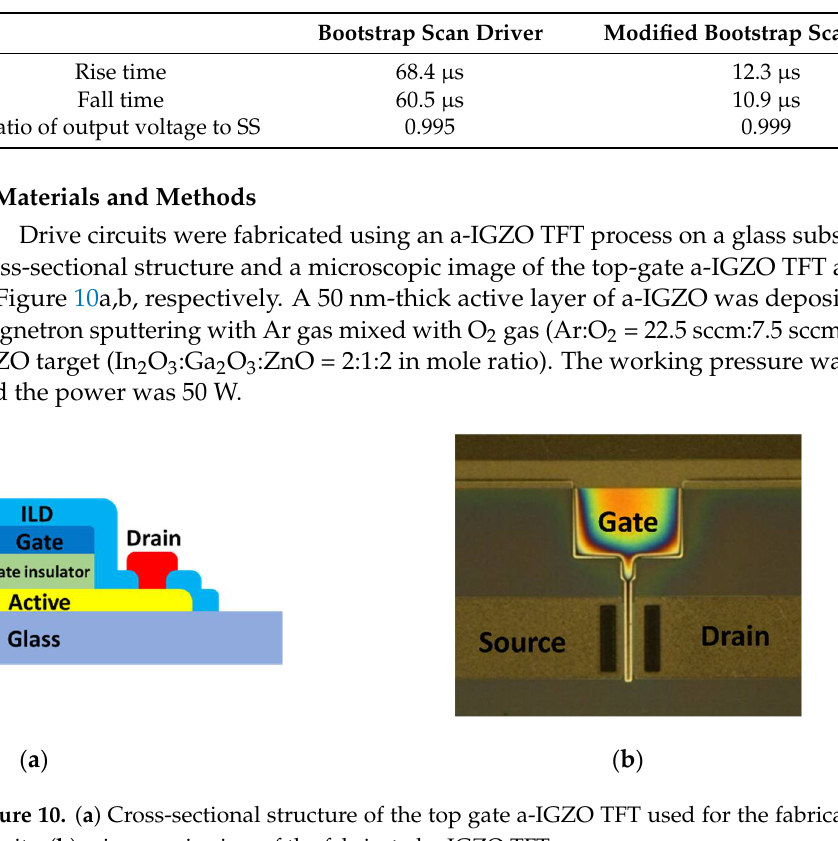
Table 2. Comparison of driving characteristics of bootstrap scan driver and modified bootstrap scan driver.